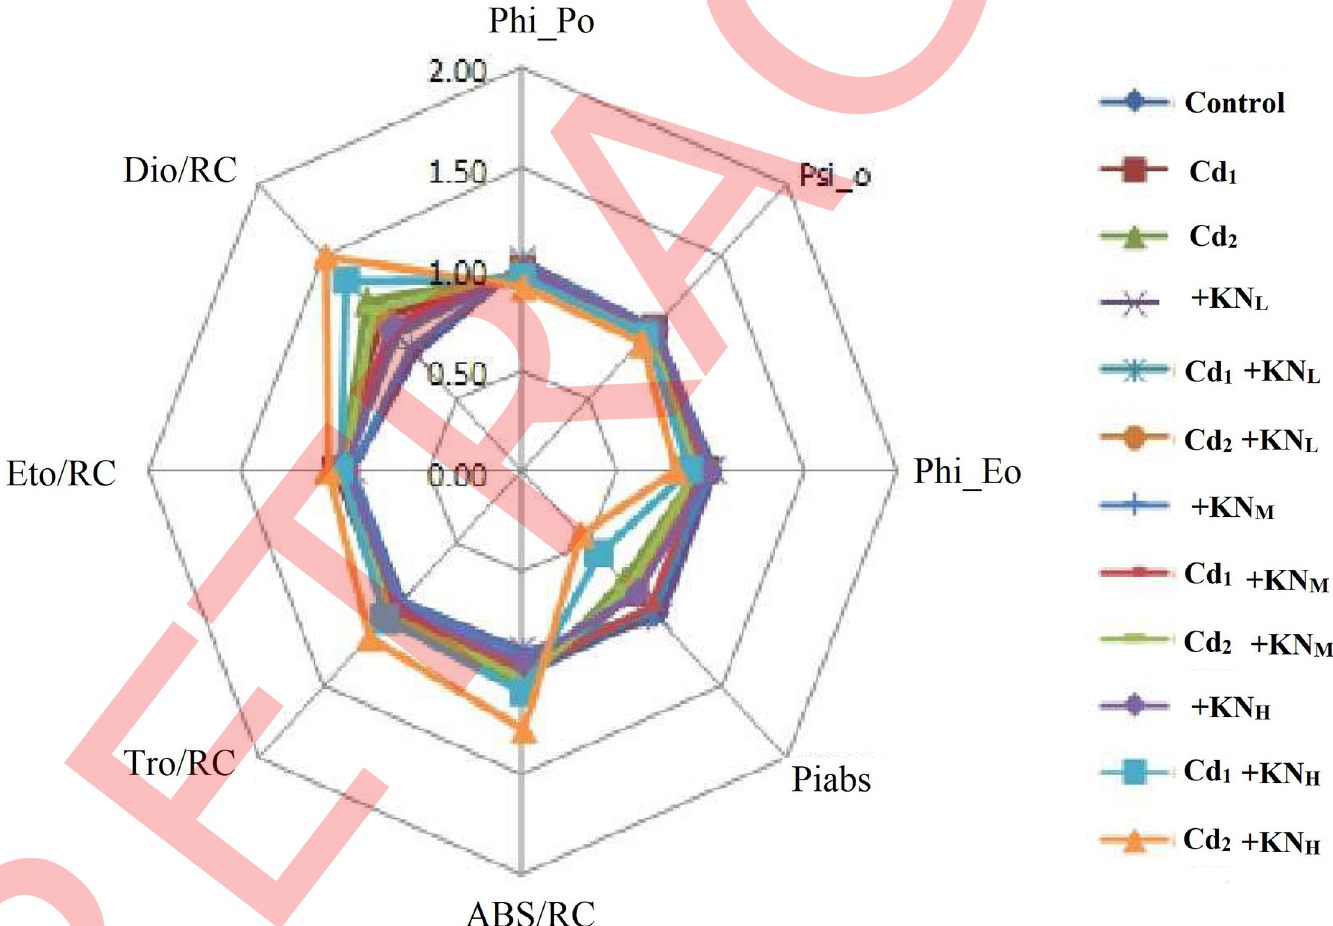
Fig 3. Impact of foliar application of KN on JIP—parameters in Trigonella seedlings exposed to Cd stress.